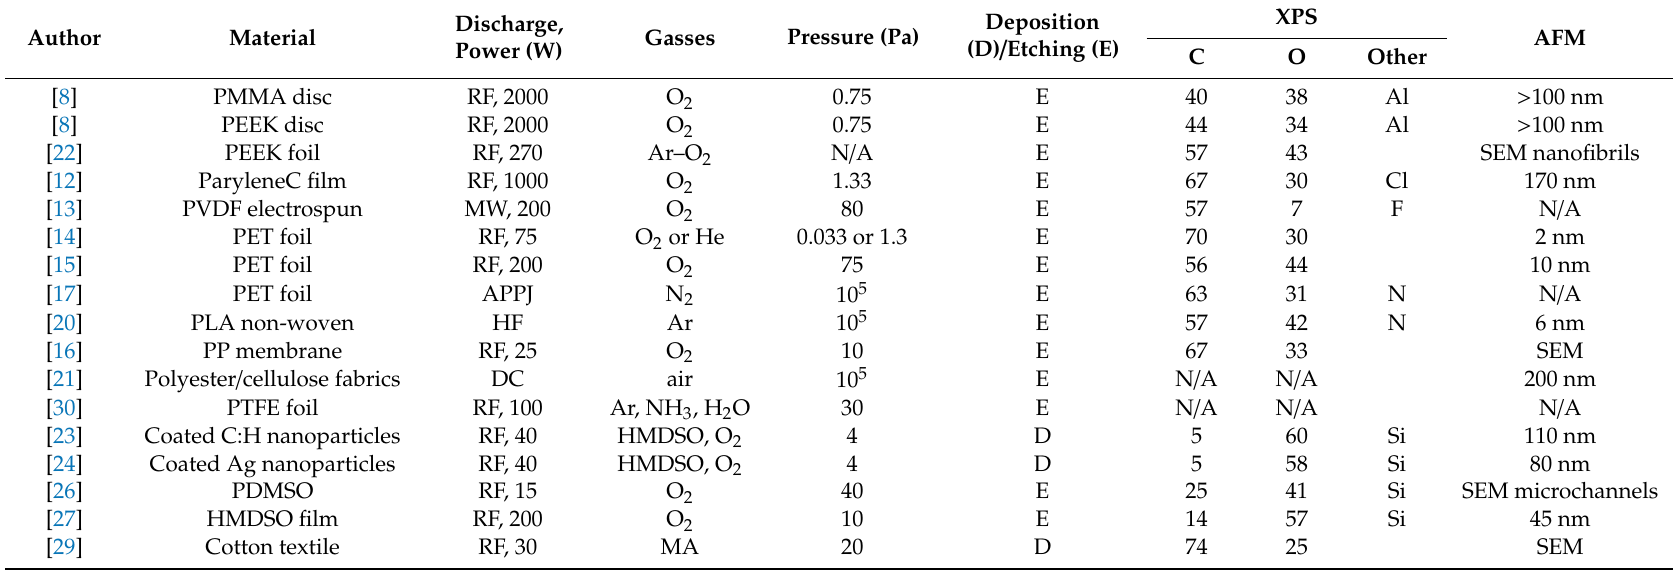
Table 1. Summary of the recent papers reporting super-hydrophilic surface finish of